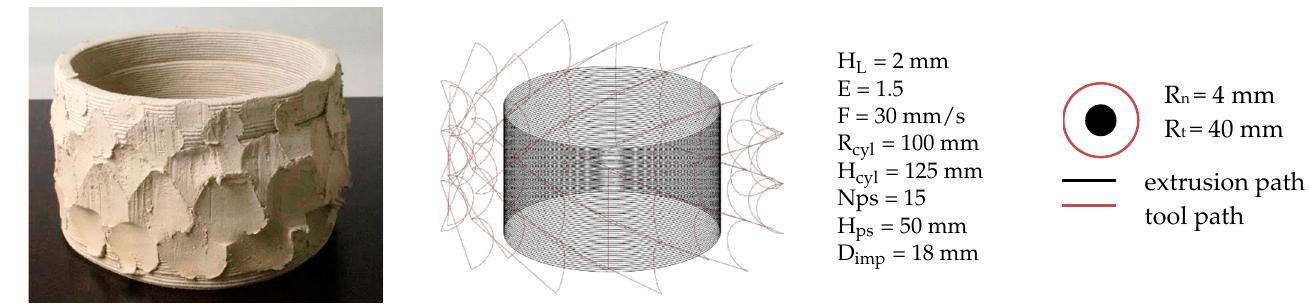
Table 6. Comparison of Grasshopper modelling as complex path instruction (material extrusion + tool) and materialized implementation with cutting tool and round material stencil in the LDM of clay.